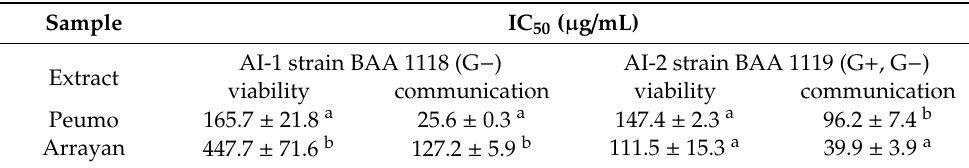
Table 5. Inhibition of quorum